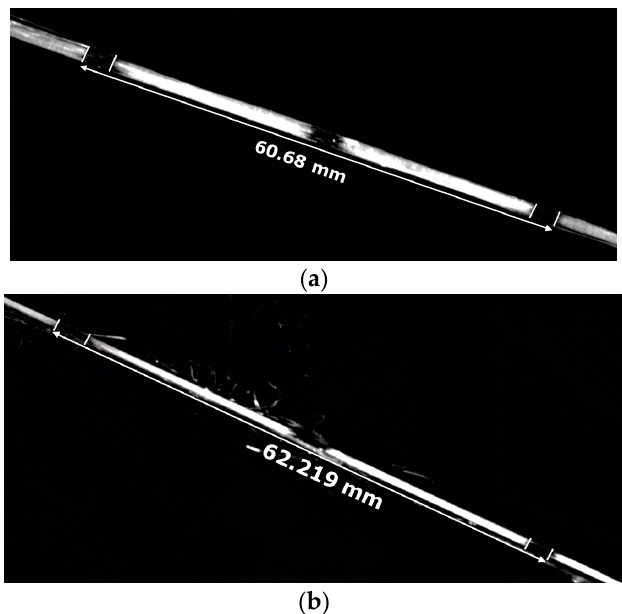
Figure 15. Distance between outer edges of the marks ( a ) before the test and ( b ) near failure.